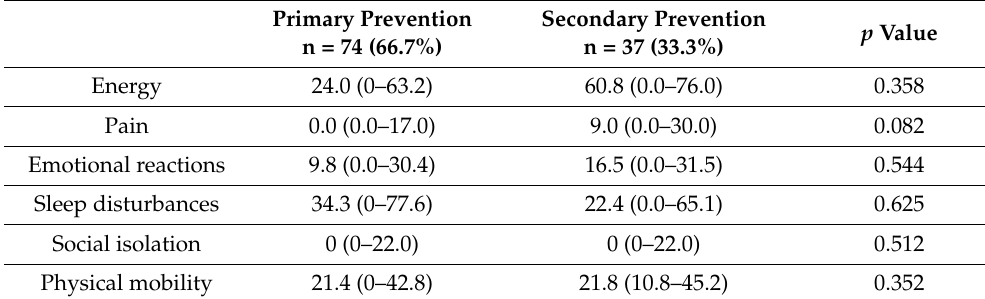
Table 6. Quality of life measured using the Nottingham Health Profile questionnaire, according to type of prevention.